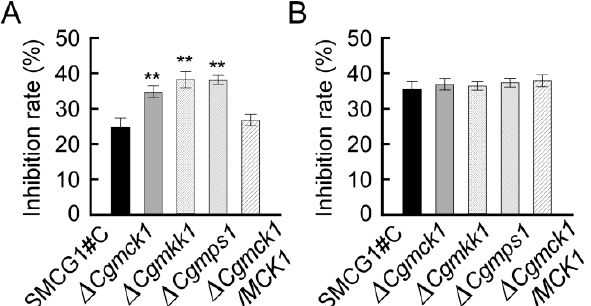
Figure 7. The ∆ Cgmck1 mutant showing higher sensitivity to biocontrol agent Bacillus velezensis . ( A ) Antifungal activities of the bacterial biocontrol agent B. velezensis against the wild type SMCG1#C, ∆ Cgmck1 , ∆ Cgmkk1 , ∆ Cgmps1 and ∆ Cgmck1 / MCK1 . ( B ) Antifungal activities of the fungal biocontrol agent Epicoccum sp. against the wild type SMCG1#C, ∆ Cgmck1 , ∆ Cgmkk1 , ∆ Cgmps1 and ∆ Cgmck1 / MCK1 . Error bars represent the SD, and asterisks indicate statistically significant differences ( p < 0.01).